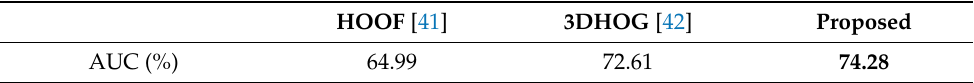
Table 4. CASME II dataset. Comparisons between AUC (area under the ROC curve) values pro- vided by the proposed method (with the best parameters setting), the 3D-HOG-based ME spotting method [42] and the HOOF-based ME spotting method [41]. The best result is in bold. HOOF [41] 3DHOG [42] Proposed AUC (%) 64.99 72.61